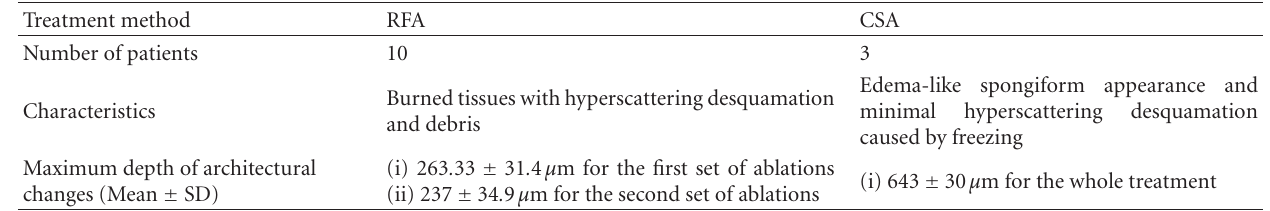
Table 1: Summary of the comparison between RFA and